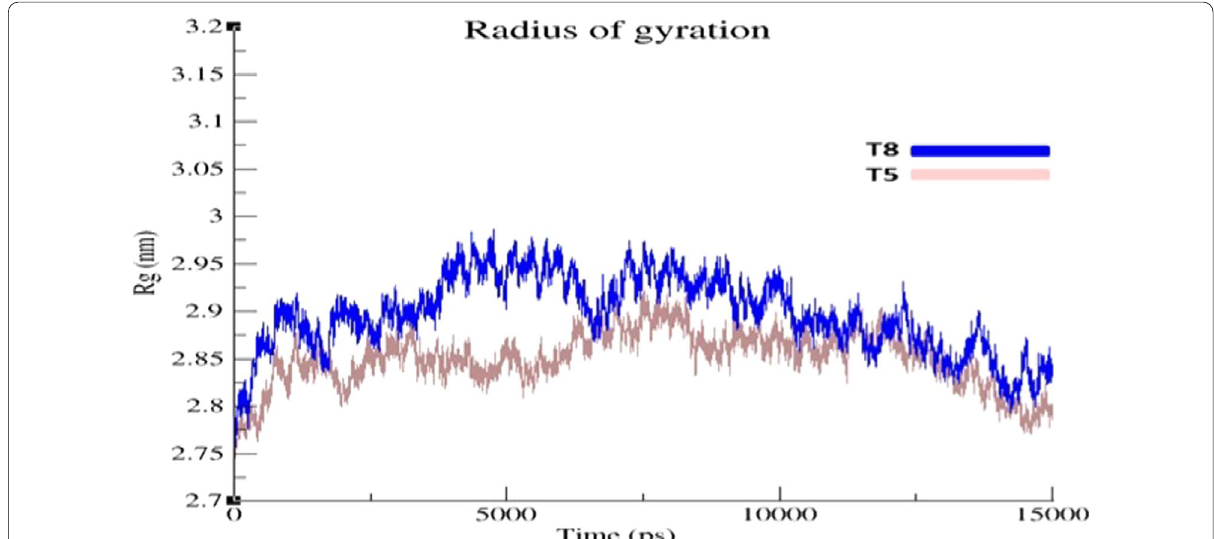
Fig. 6 Radius of gyration (Rg) graph of T5 and T8 targeted protein at different time scales from 0 to 15,000 ps